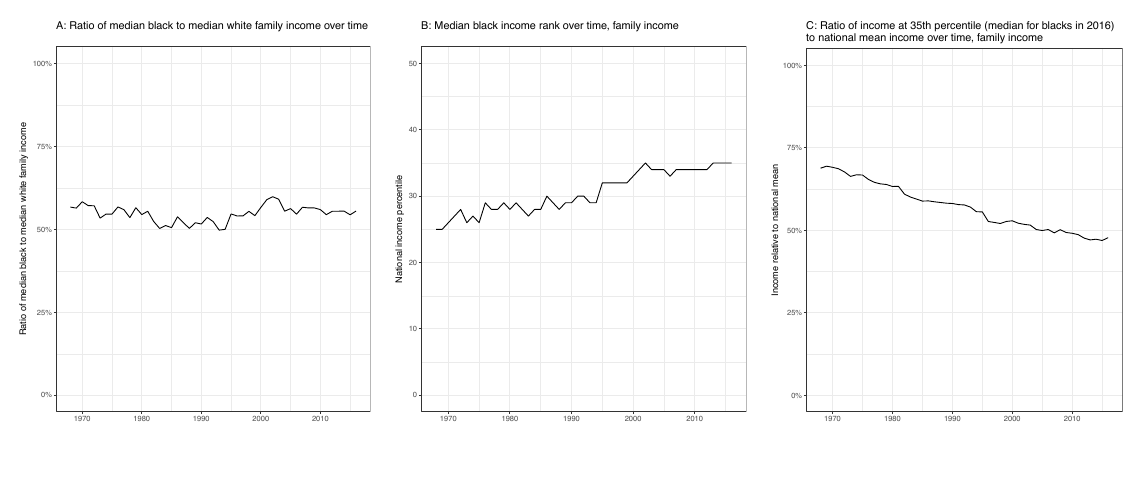
Figure 3: Median black-white family income ratio, median black rank, and income at the 35th percentile as a percentage of the national mean over